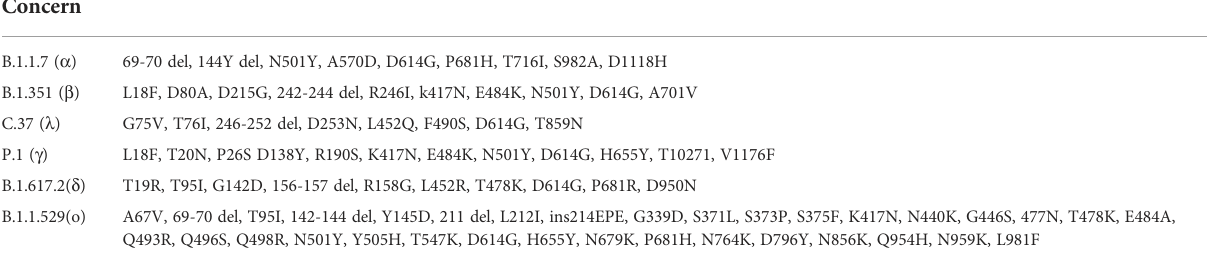
TABLE 2 Spike substitutions of all VOCs relative to ancestral Wuhan lineage in this